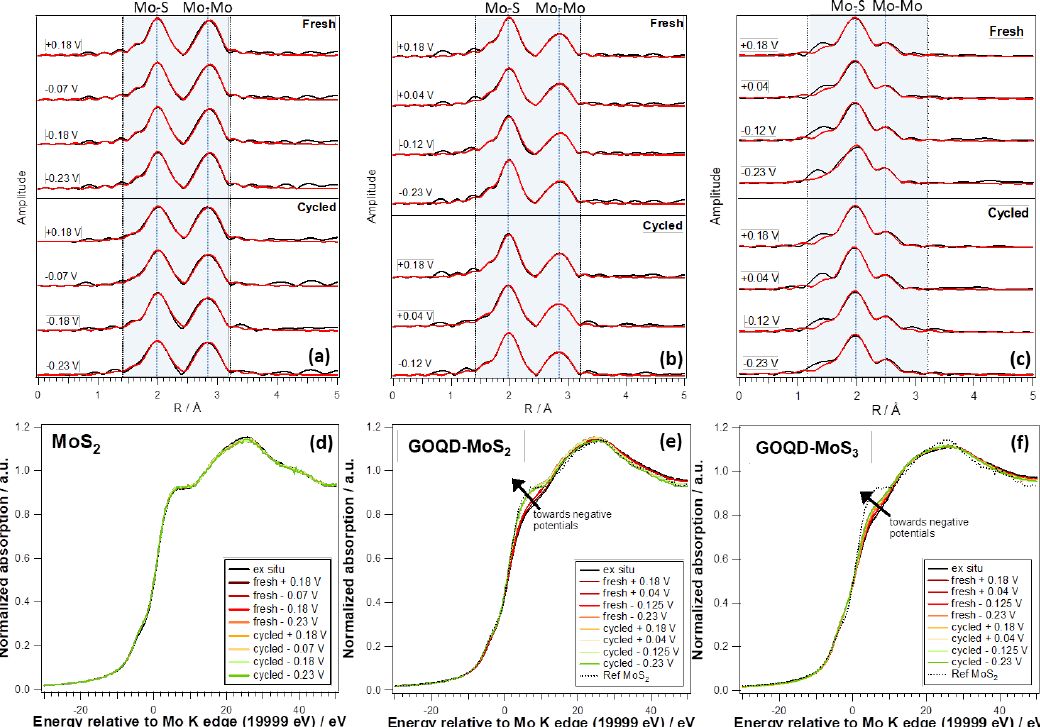
Figure 3. Fourier transformed EXAFS ( a , b , c ) and XANES spectra ( d , e , f ) at Mo K edge for the fresh and aged MoS 2 (Aldrich) ( a , d ), GOQD-MoS 2 ( b , e ) and GOQD-MoS 3 ( c , f ) nanohybrids recorded at different applied potentials. The black and red curves represent the experimental data and the corresponding fit, respectively.